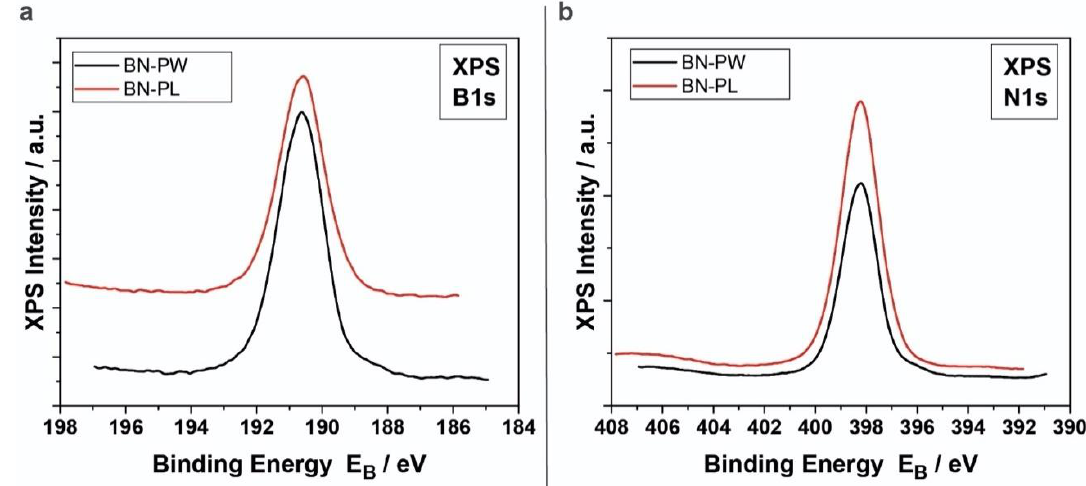
Figure 4. B1s ( a ) and N1s ( b ) XP spectra of BN nanopowder (BN-PW) and BN platetets (BN-PL) samples.